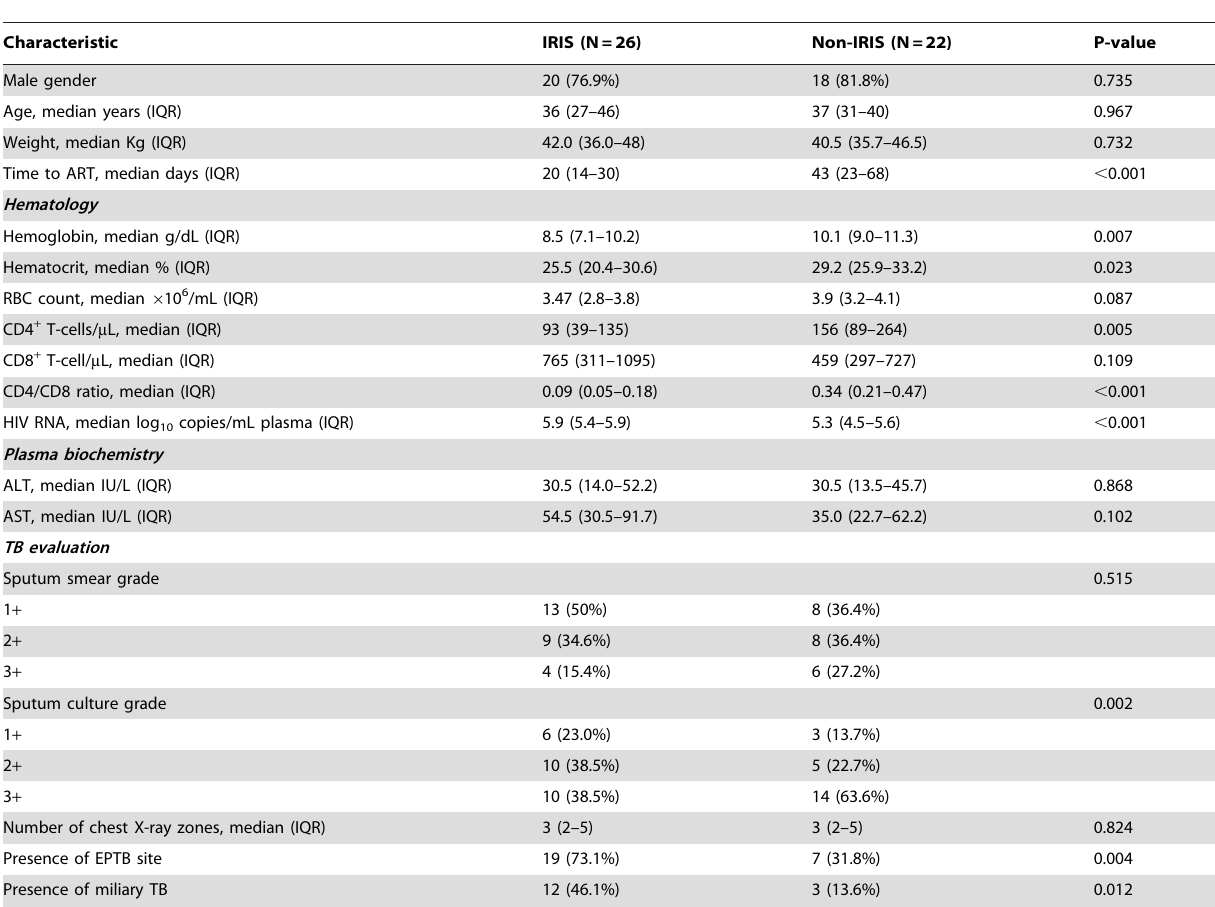
Table 2. Baseline characteristics of the study population stratified by IRIS status.